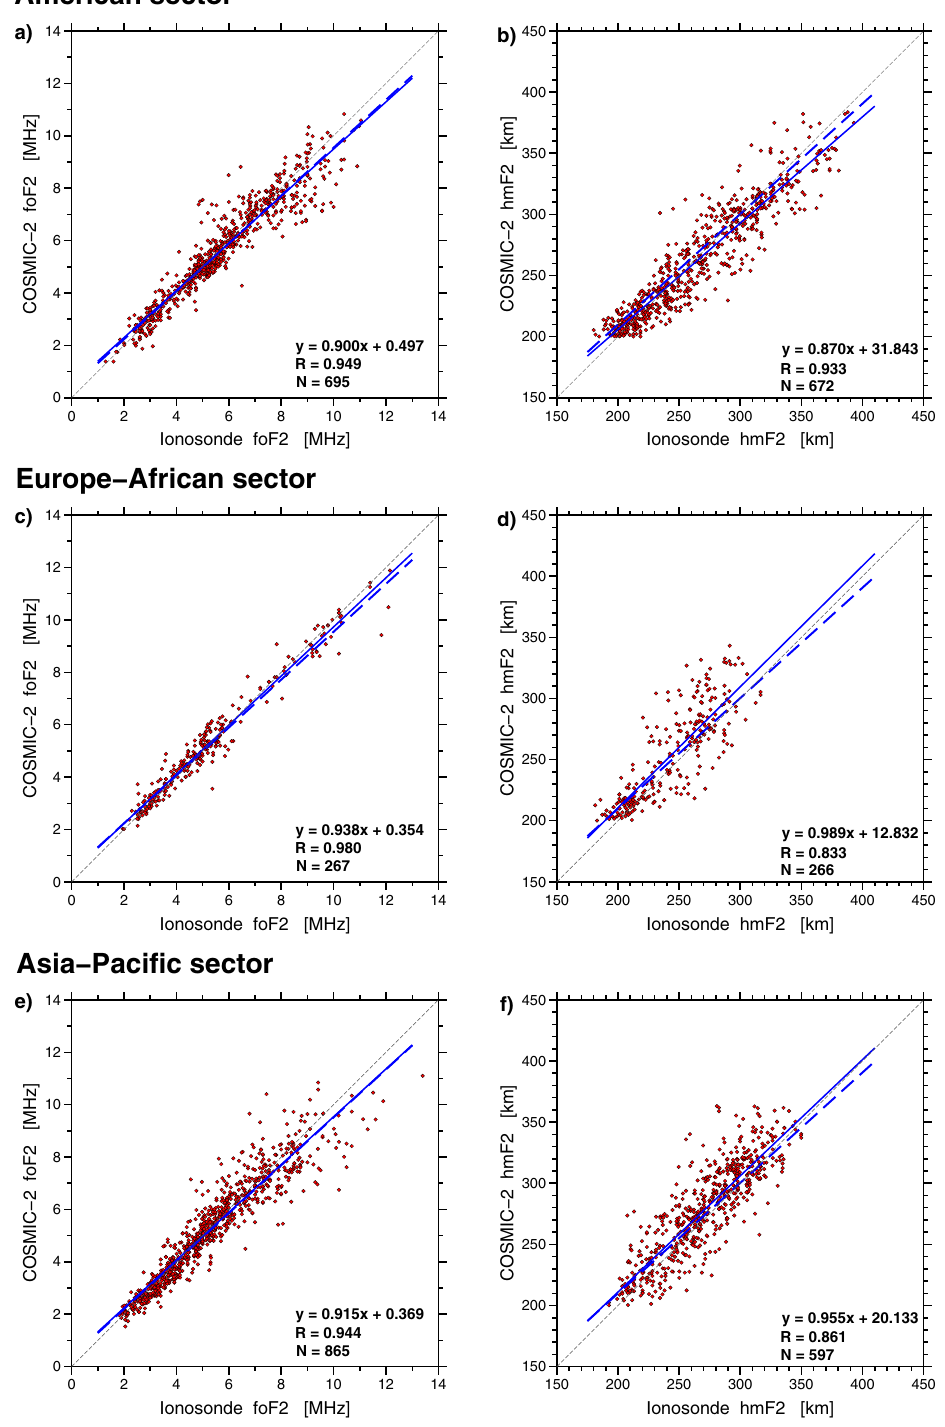
Fig. 4. Scatter plots of the COSMIC-2 RO-based foF2 and hmF2 values against the corresponding ionosonde-derived ones with a separation to American, Europe-African, and Asia-Paci fi c longitudinal sectors. The solid blue lines show the best fi t line, while the dashed blue lines show the best fi t lines without zone separation (Fig.